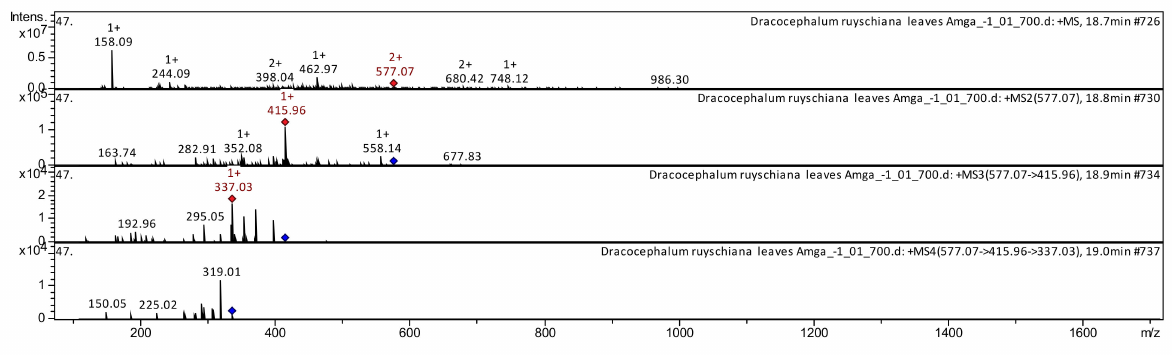
Figure 10. CID spectrum of procyanidin from extracts of D. ruyschiana , m / z